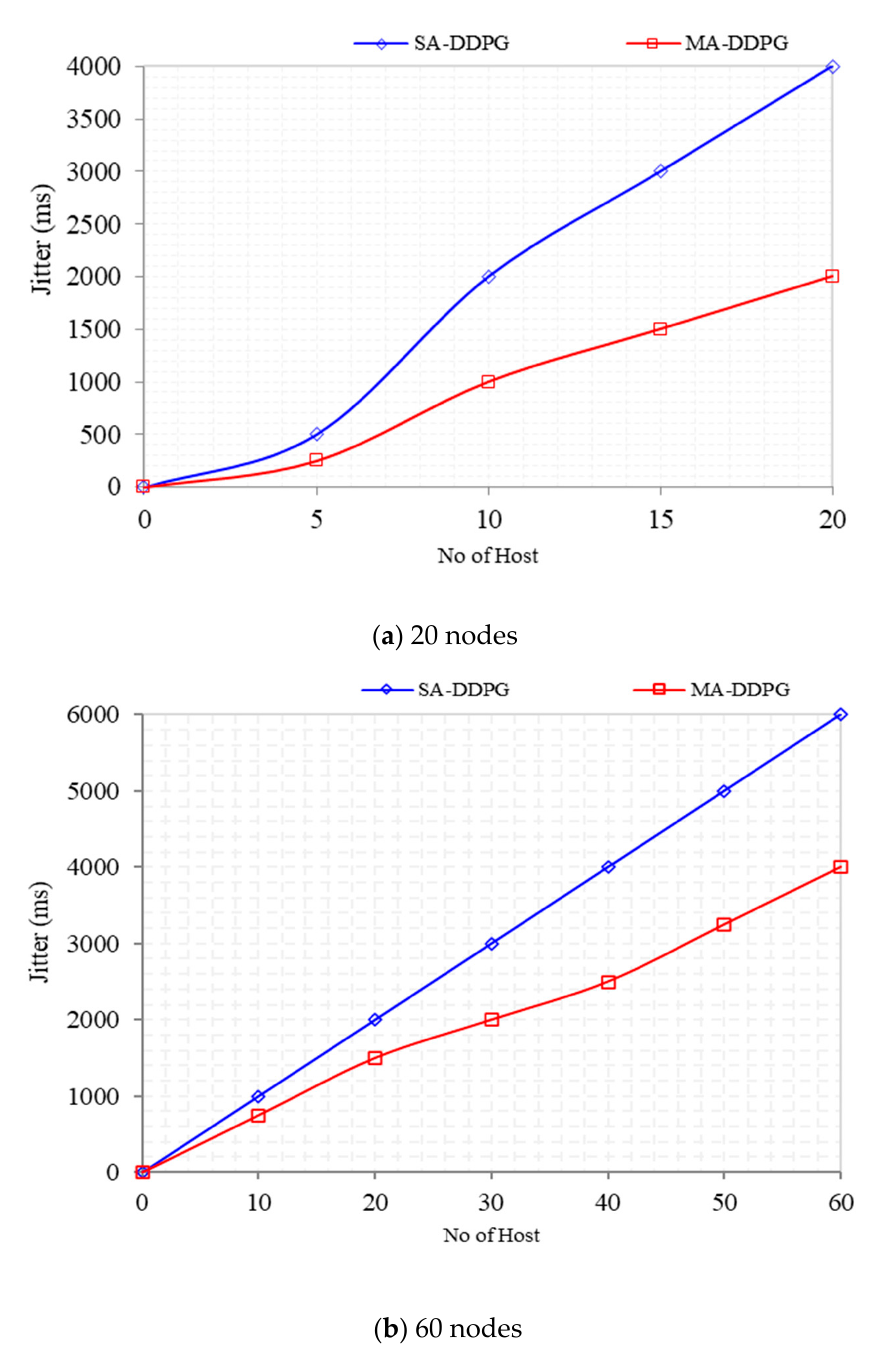
Figure 11. Jitter vs. no. of hosts for SA ‐ DDPG and MA ‐ DDPG.